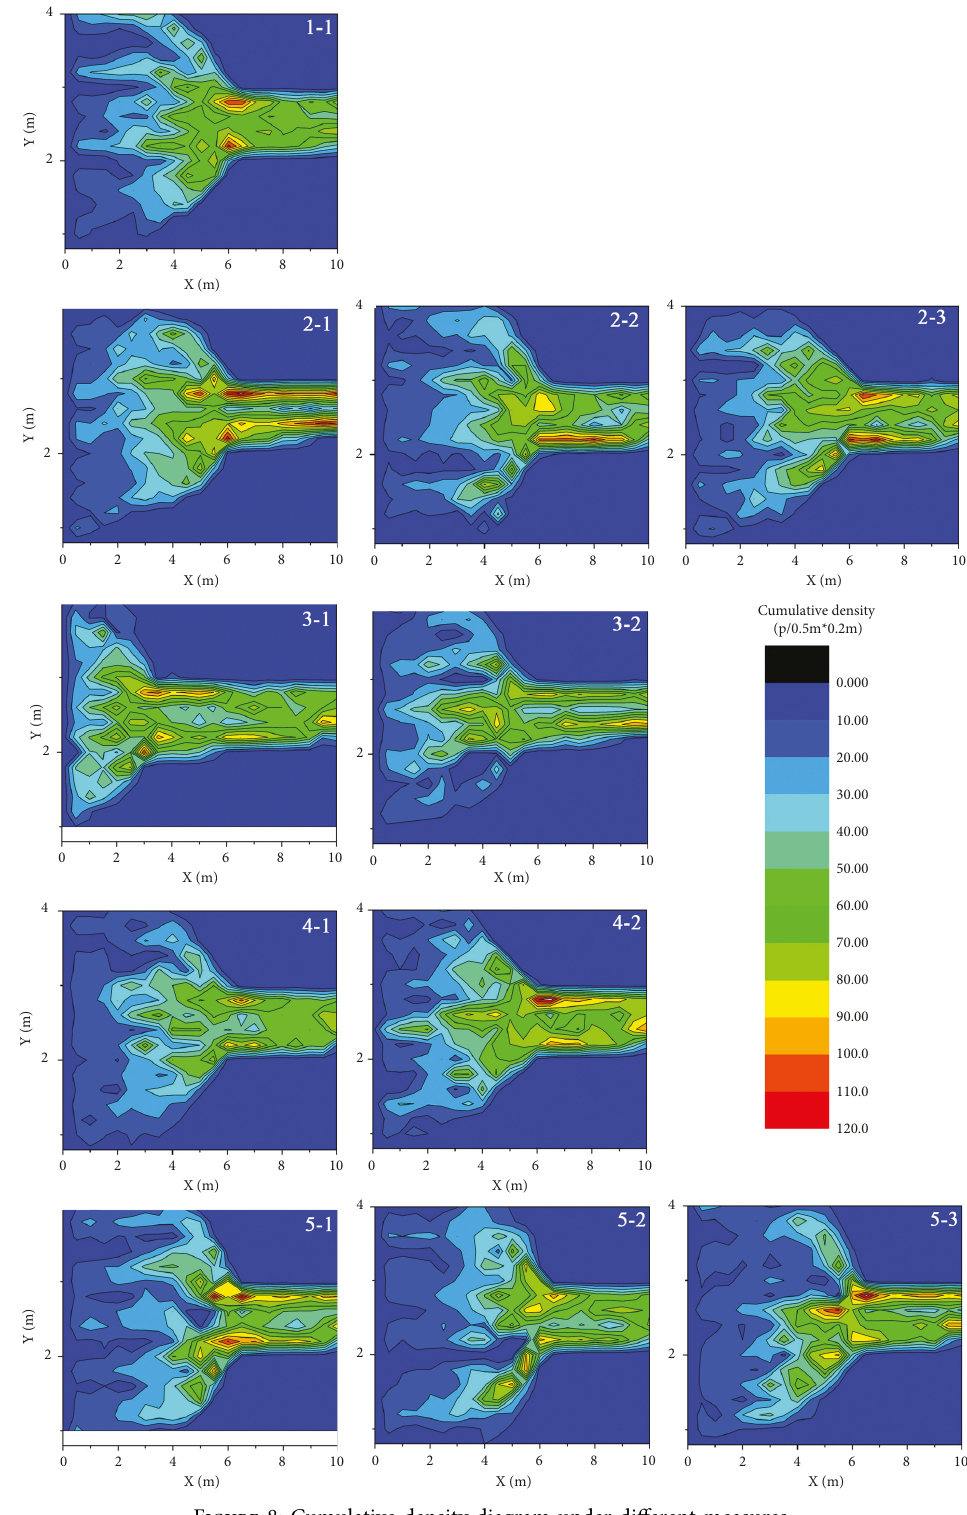
Figure 8: Cumulative density diagram under different